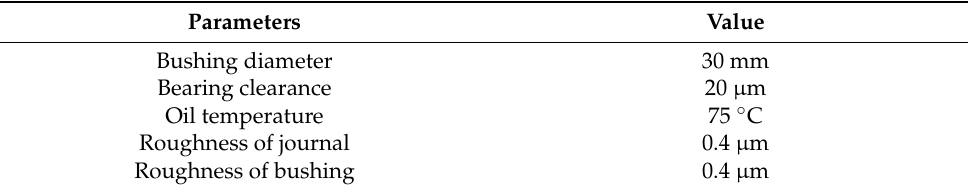
Table 3. Lubrication parameters of the test